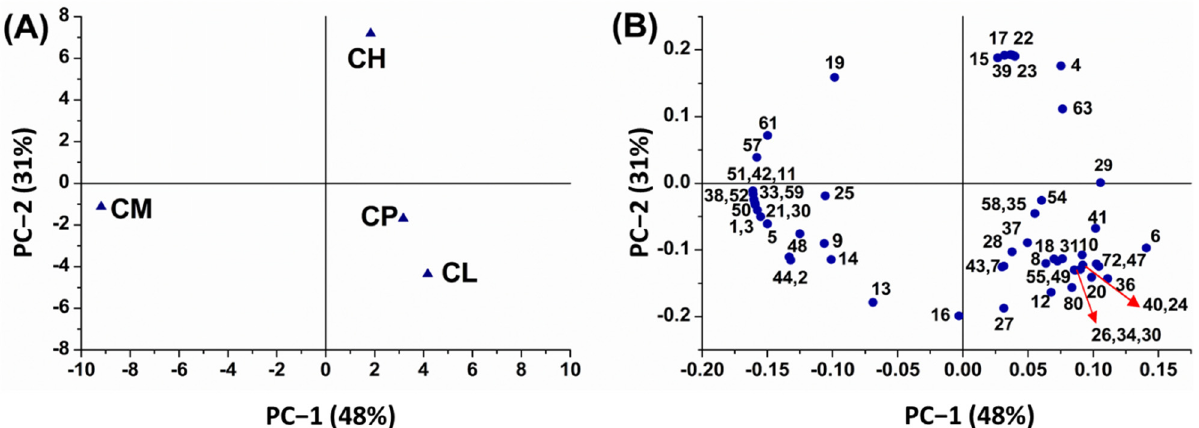
Figure 3. Principal component analysis (PCA) of the identified volatile compounds in leaf essential oils derived from four Citrus species. ( A ) Score plot, and ( B ) loading plot. C. hystrix (CH), C. limon (CL), C. pyriformis (CP), and C. microcarpa (CM). The peak numbering refers to Table S1 (Supplementary Information).